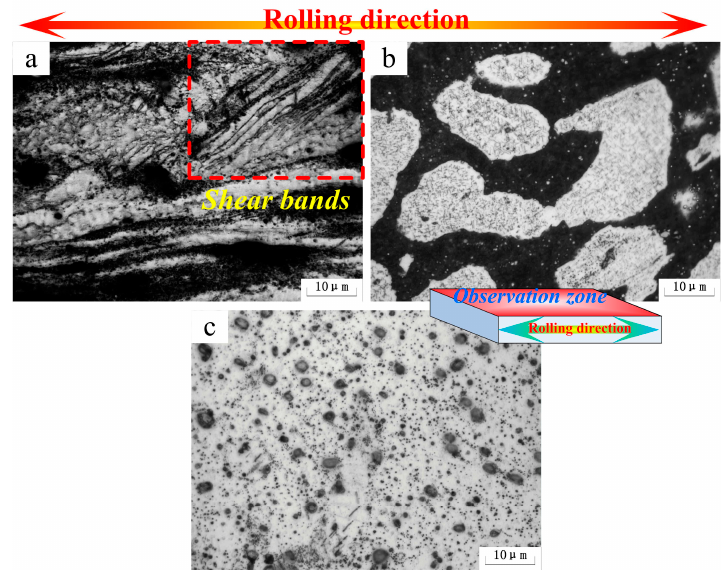
Figure 4. Microstructure of as-rolled alloys: ( a ) Mg-5Li-3Al-2Zn-0.2Y; ( b ) Mg-8Li-3Al-2Zn-0.2Y; ( c ) Mg-11Li-3Al-2Zn-0.2Y.